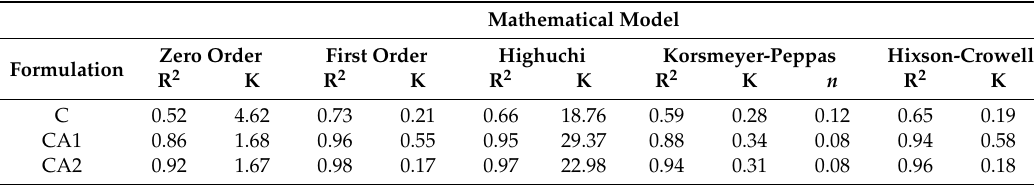
Table 5. Mathematical characteristics of MF dissolution.